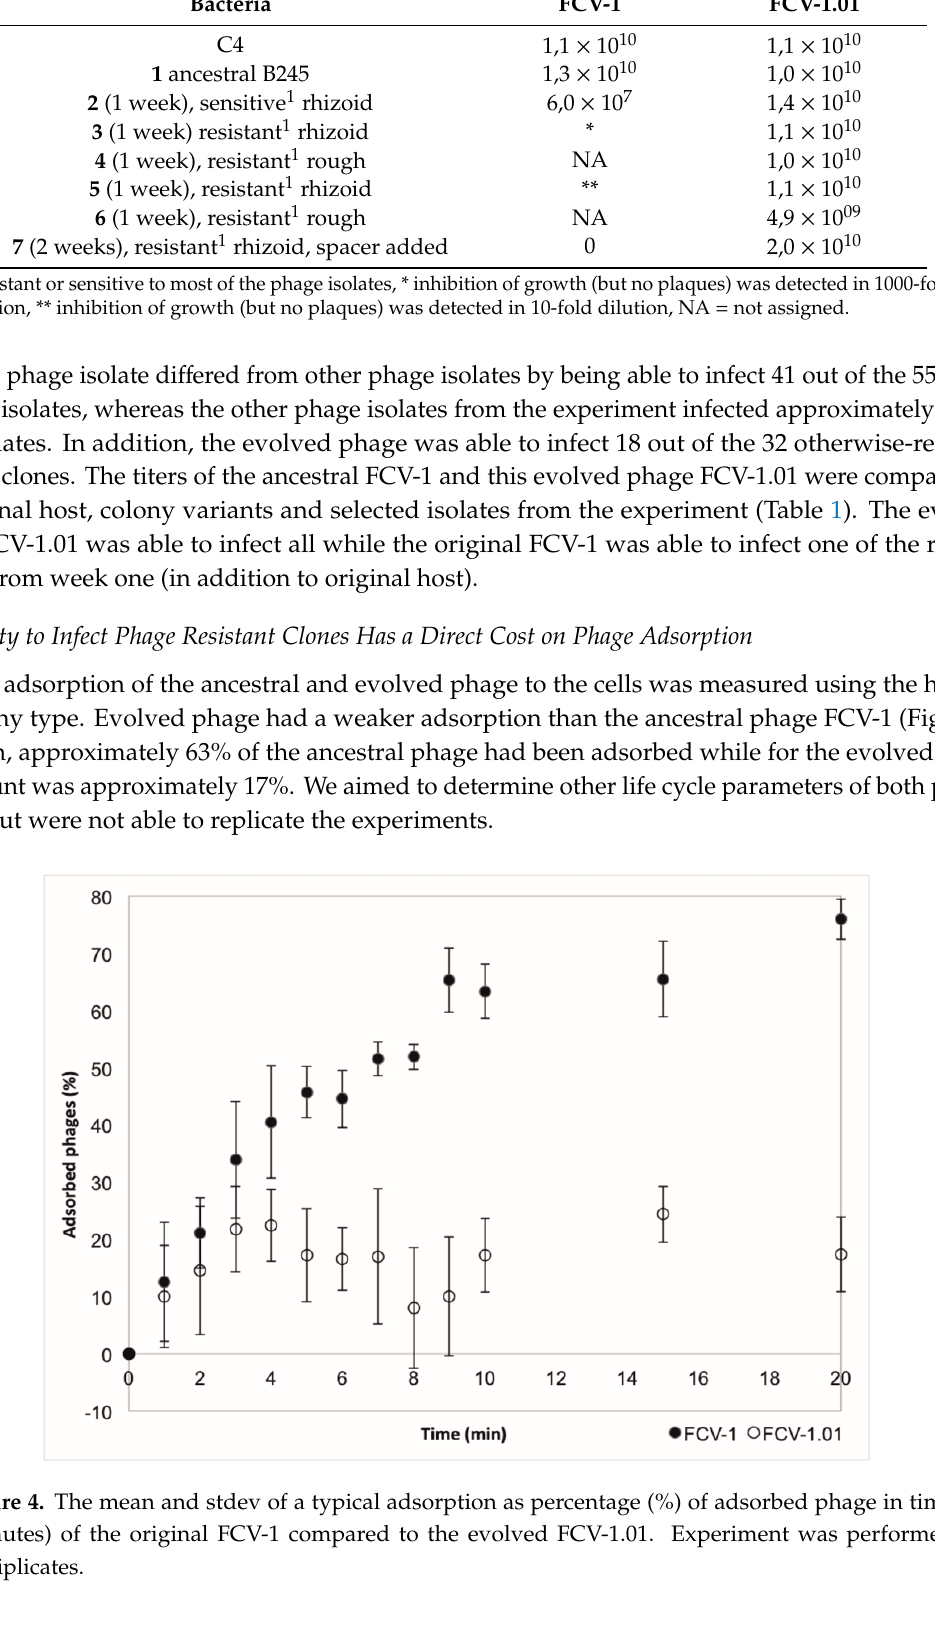
Table 1. Titers (PFU/mL) of ancestral FCV-1 and evolved FCV-1.01 on selected isolates (number in bold before strain corresponds the bacterial strains marked in Figure 3).